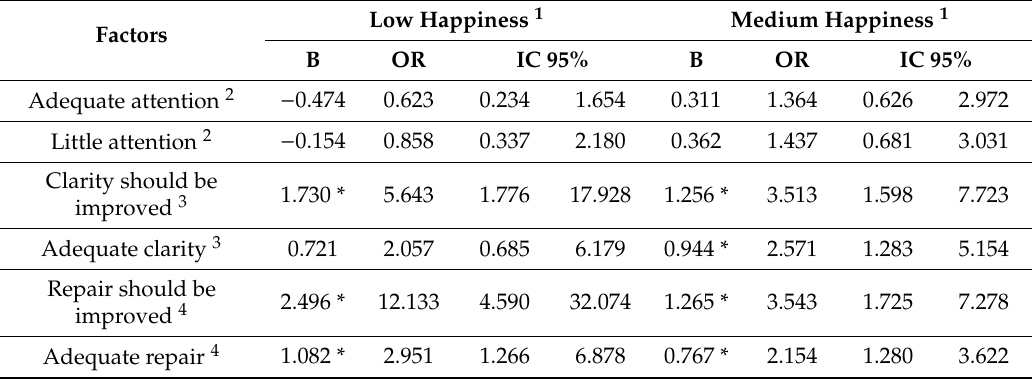
Table 3. Multinomial logistic regression model examining the probability of perceiving high happiness according to the degree of emotional attention, clarity, and repair.